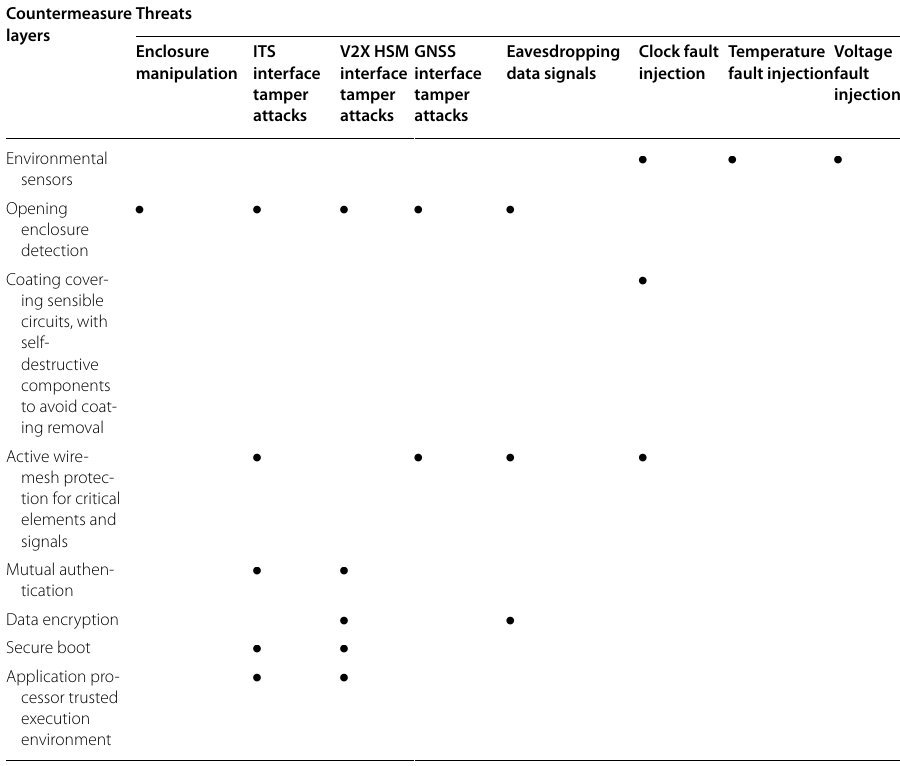
Table 1 Relationship between countermeasure and possible threats for the OBU Countermeasure